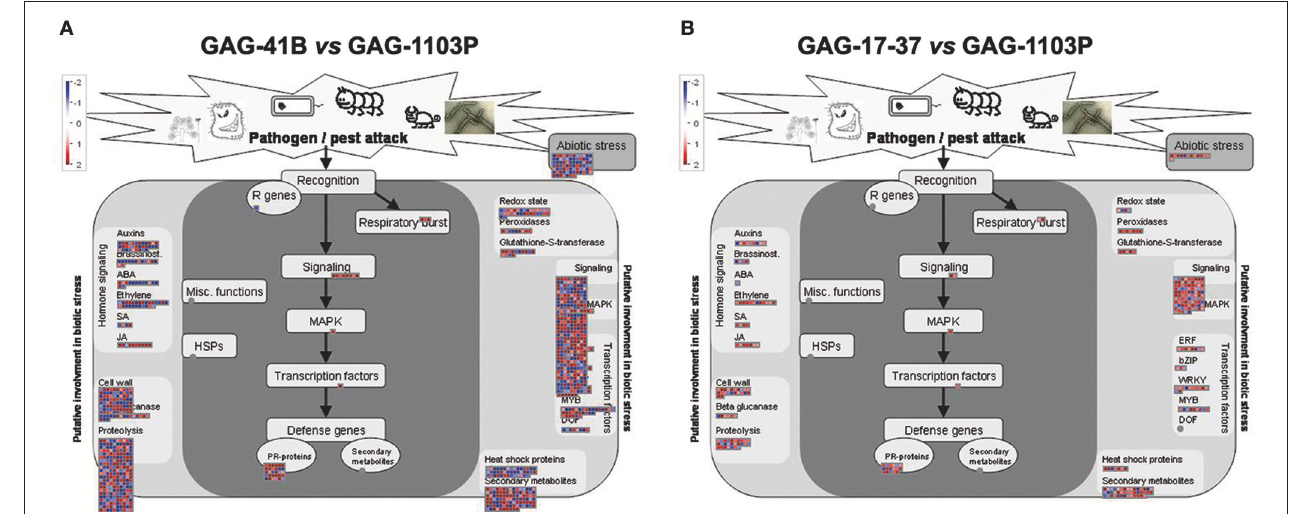
FIGURE 2 | MapMan software output to provide an overview of the effect of 41 B Mgt rootstock (A) and 17–37 Mgt rootstock (B) induced on biotic stress responses and, in particular, on secondary metabolism. Log 2 fold changes values referred to GAG-1103P are represented. Up-regulated and down-regulated transcripts are shown in red and blue,